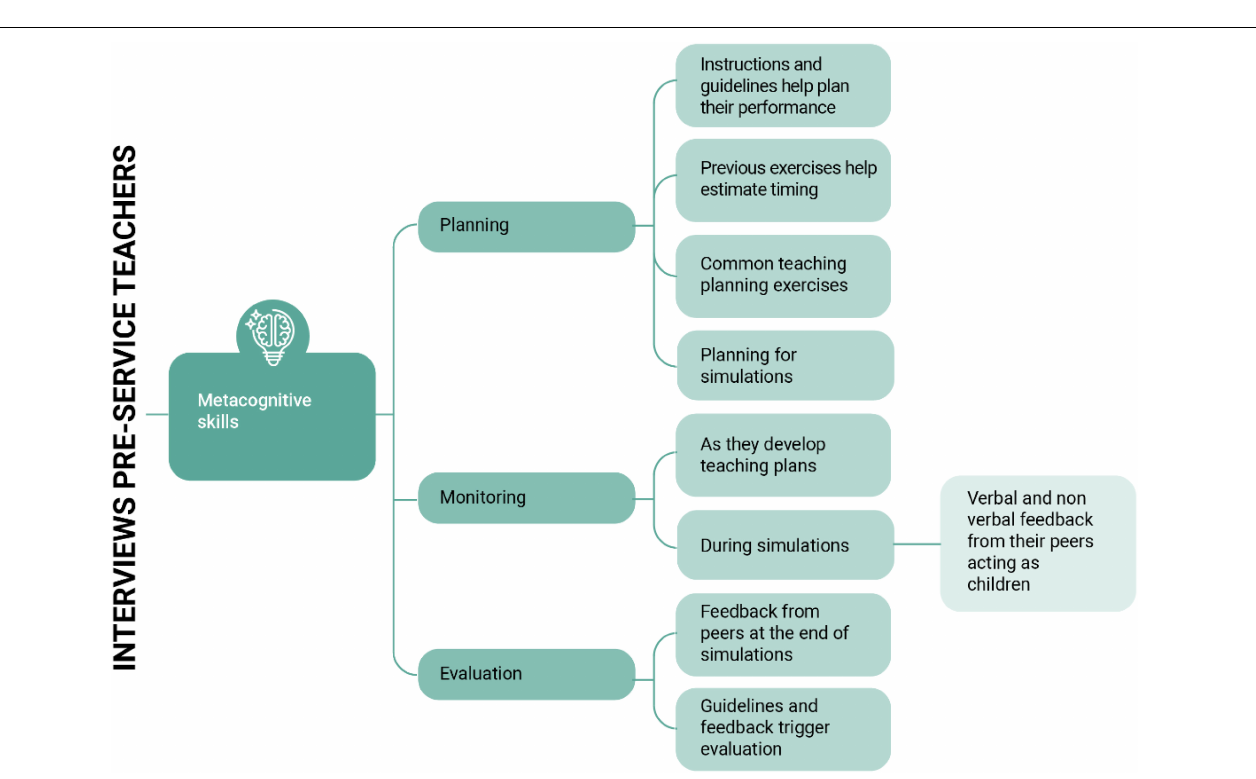
FIGURE 6 | Development of lifelong learning trends in the assessment tasks. Synthesis of findings in the interviews with the pre-service teachers.